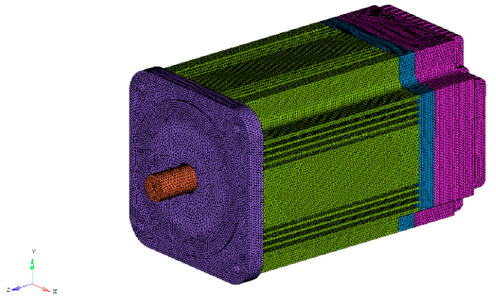
Figure 3. 3-D entire finite element model of the BLDC motor.